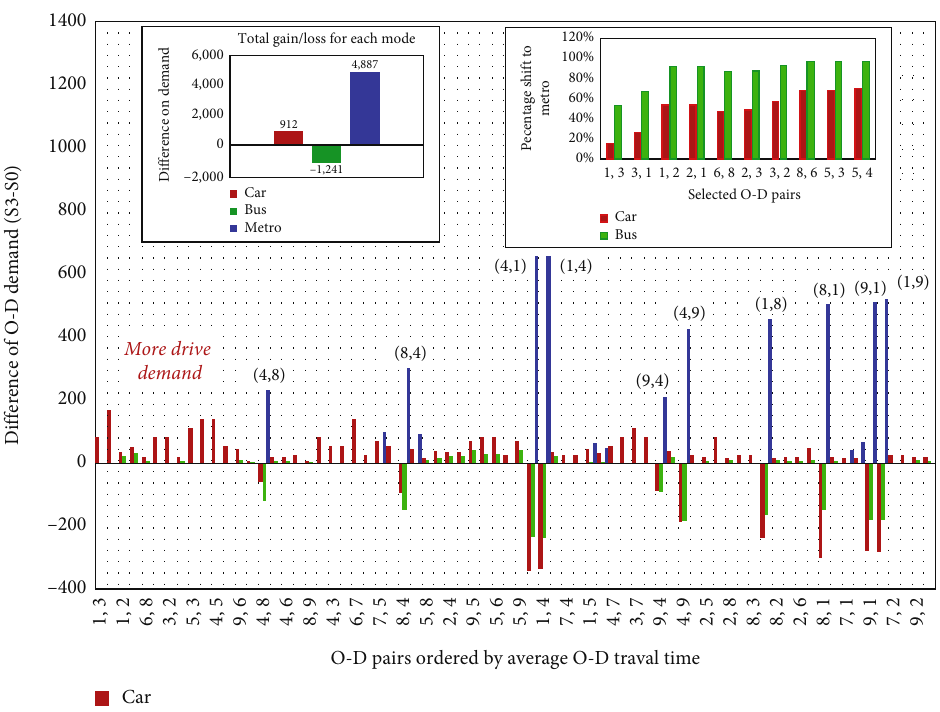
Figure 18: Comparison of multimodal OD demands before and after building new metro line.